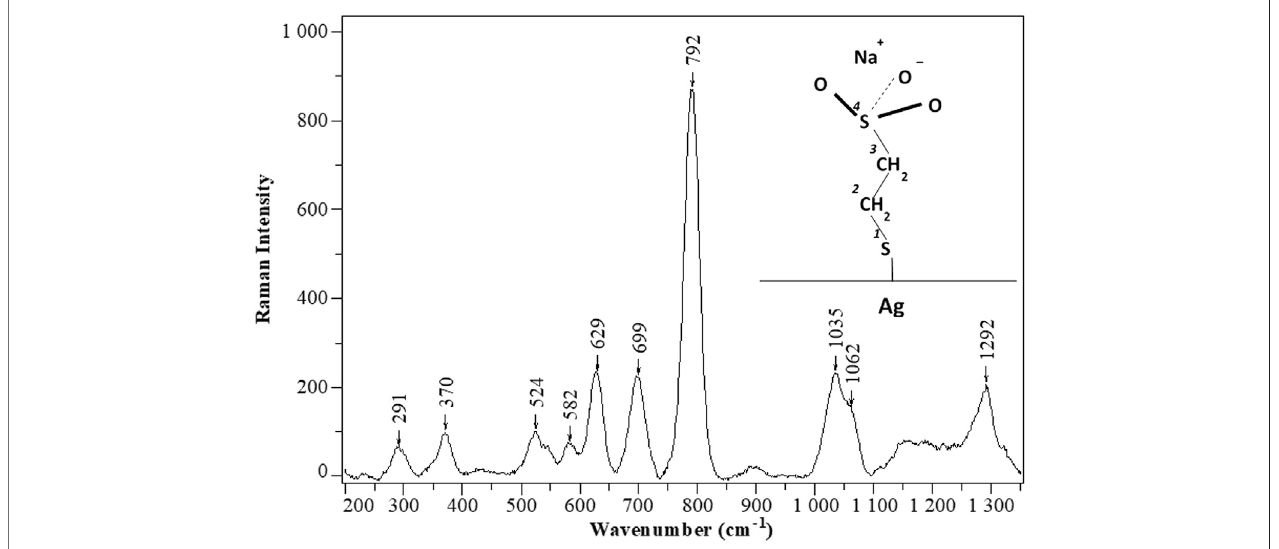
FIGURE 5 | Typical SERS spectrum ( λ exc (cid:2) 632.8 nm, 3 × 10 s acquisition time, laser power on the sample around 0.75 mW) of MES adsorbed on Fe 3 O 4 /Ag nanocomposite.Thespectrumwasbaselined fortheclarityofpresentation. Inset:schematic structure oftheMESNa moleculeadsorbedonsilverin trans conformation.